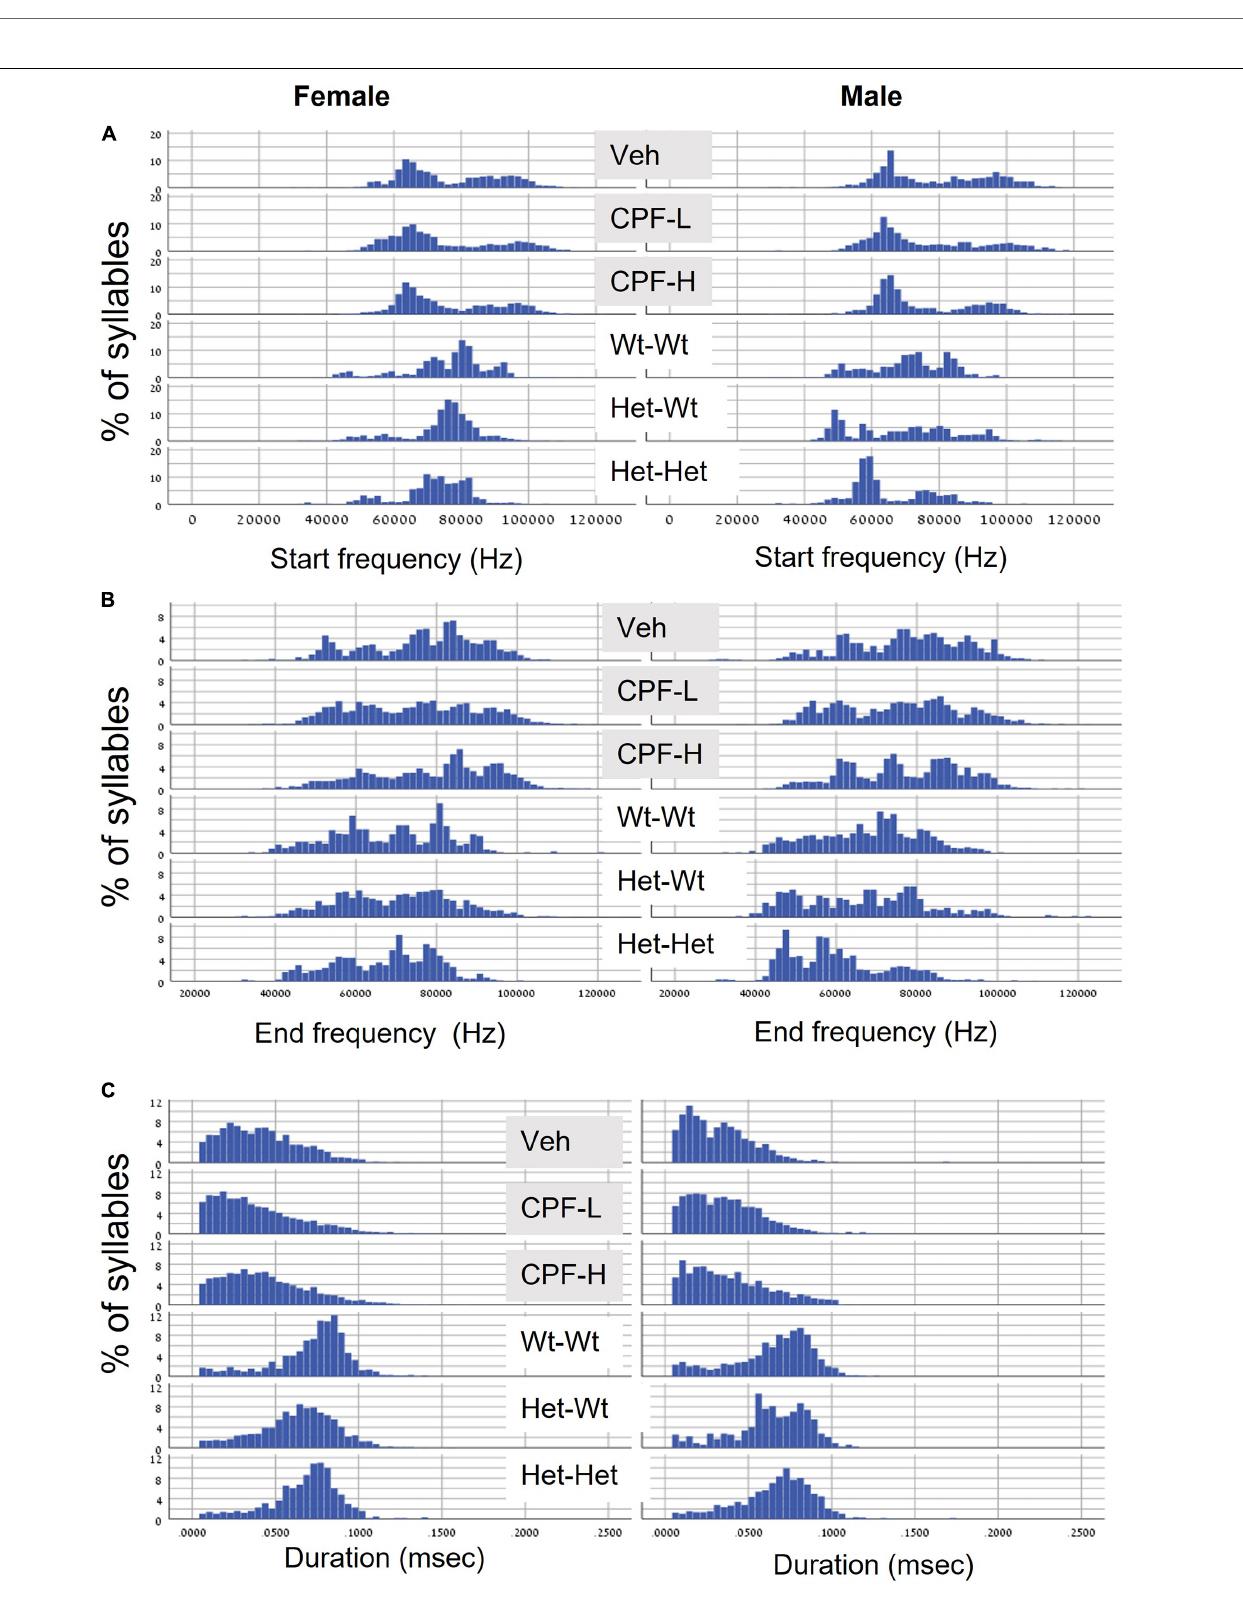
FIGURE 1 | CPF treatment and Mthfr+/– genotype alters the distribution of isolation induced syllables in female and male pups. (A) Start frequency. (B) End frequency. (C) Duration. For each variable, the following groups are presented from top to bottom: Vehicle (Veh), CPF low dose (CPF-L), CPF high dose (CPF-H), Wt:Wt, Het-Wt, and